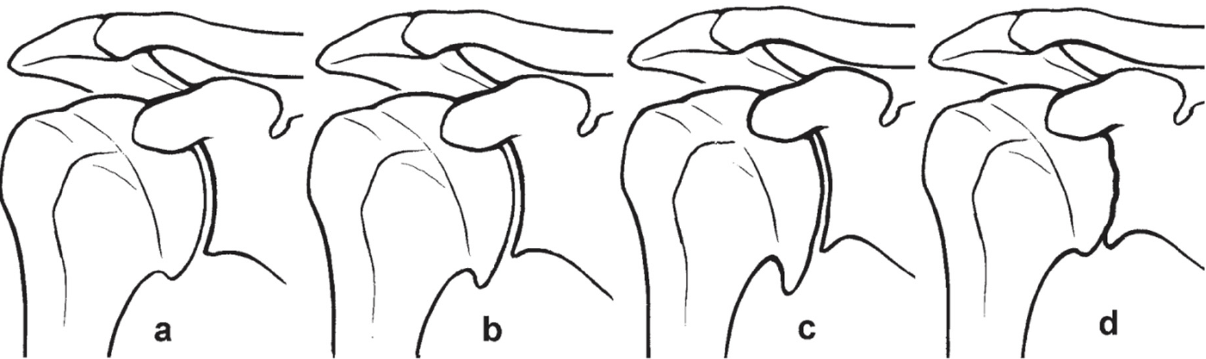
Figure 2. Image modified from Buscayret et al. [15]. ( a ): humeral osteophyte < 3 mm. ( b ): humeral osteophyte > 3 mm and <8 mm. ( c ): humeral osteophyte >8 mm. ( d ): obliteration of glenohumeral joint space.